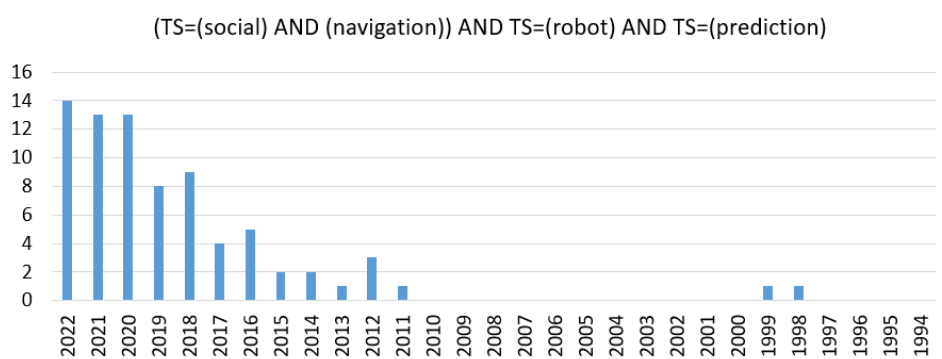
Figure 2. Web of Science Analyze filter: (TS = (social AND navigation)) AND TS = (robot) AND TS = (prediction).